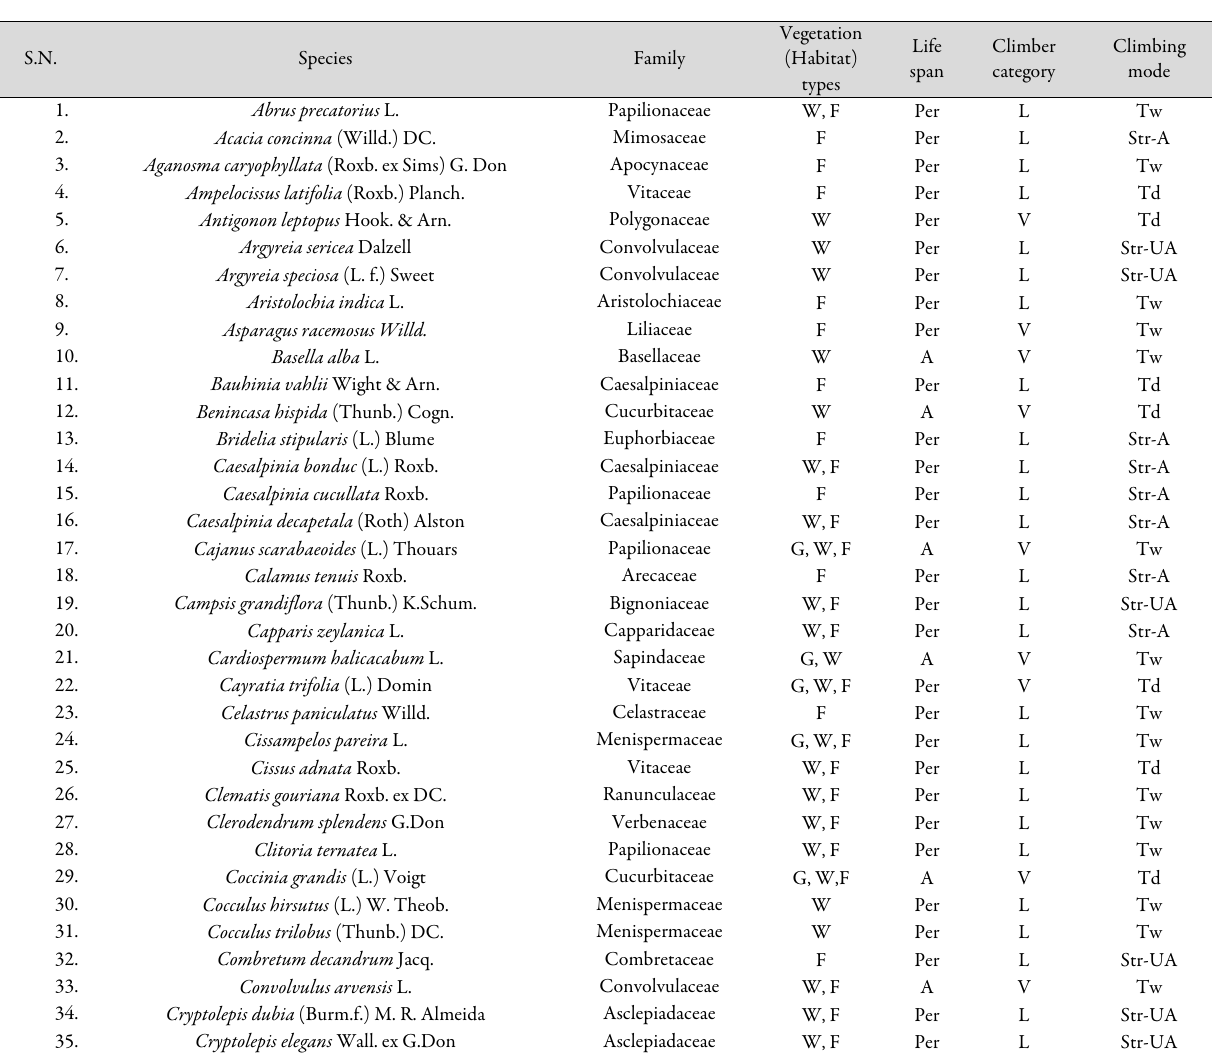
General habitat and climbing categories of climbers of north-eastern Uttar Pradesh. Vegetation (Habitat) types - G = Grassland, W = Wasteland, F = Forest. Life span- A = Annual, Per = Perennial; Climber category- L = Liana (woody climber), V = Vine (herbaceous climber); Climbing mode- Tw = Twining, Td = Tendrilar, Str-A = Straggling Armed, Str-UA = Straggling Unarmed, AR = Aerial